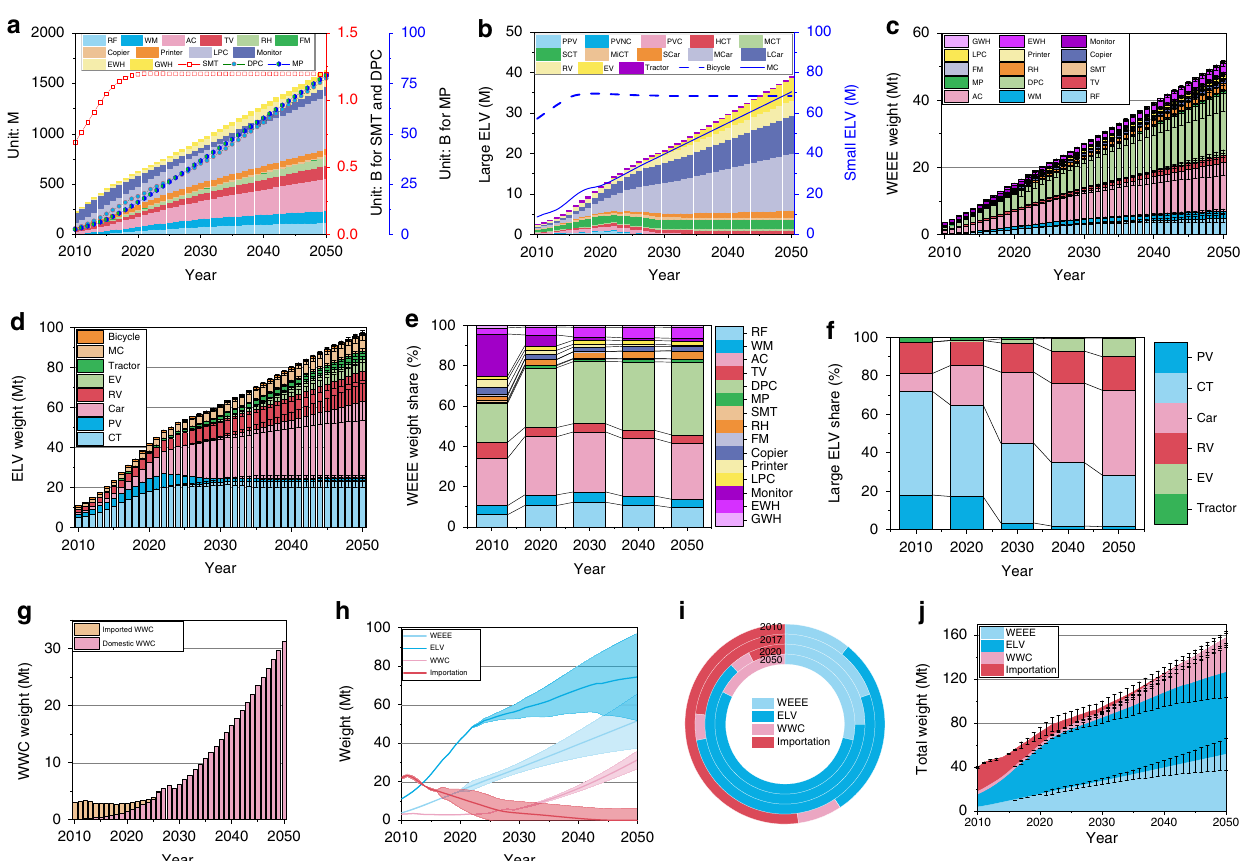
Fig. 2 Estimation of China ’ s AM from 2010 to 2050. a WEEE quantity. b ELV quantity. c WEEE weight. d ELV weight. e WEEE weight share. f ELV weight share. g WWC weight. h Weight range. i Total weight share. j Total weight. Note: WEEE consist of AC, WM, RF, TV, DPC, LPC, MP, SMT, RH, printer, copier, monitor, EWH, GWH; Large ELV consists of PPV, NPV, PVC, HCT, MCT, SCT, MiCT, SCar, LCar, RV, EV, and tractor; Bicycle and MC are classi fi ed as small ELV; And WEEE, ELV, and WWC make up AM. AC, air conditioner; AM, anthropogenic mineral; CT, cargo truck; DPC, desktop personal computer; ELV, end-of-life vehicle; EV, electric vehicle; EWH, electric water heater; FM, fax machine; GWH, gas water heater; HCT, heavy cargo truck; LCar, large